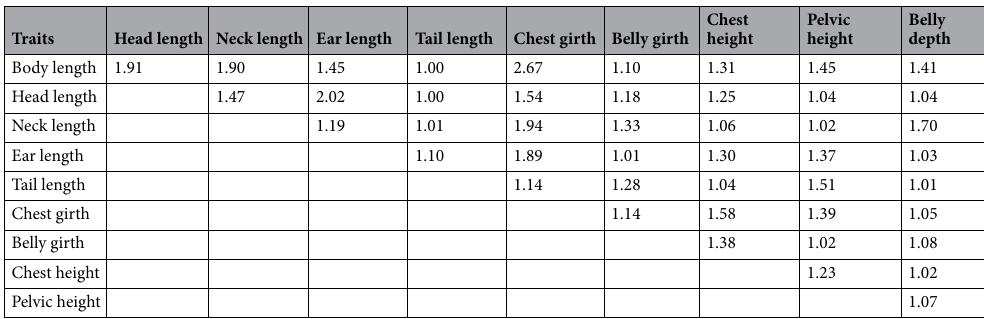
Table 4. Variance inflation factors (VIF) for the relationships between body dimensions (cm) of Bohor reedbuck.